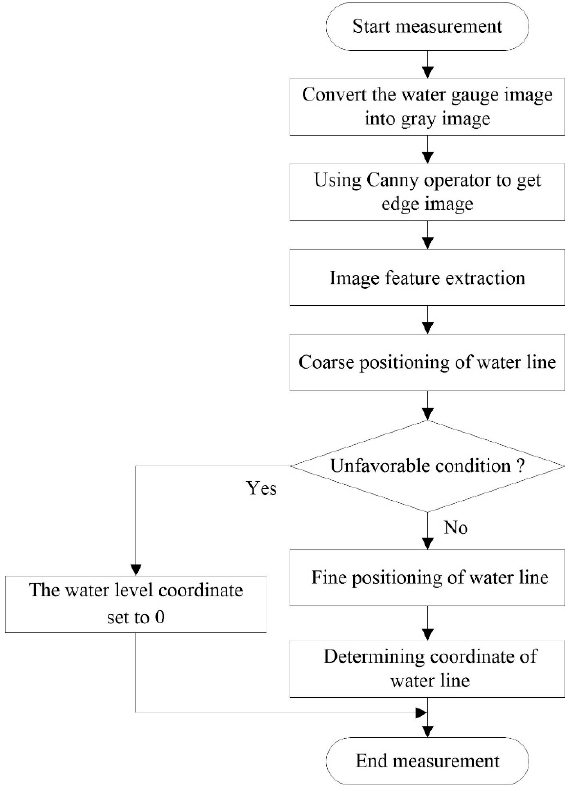
Figure 6. Maximum mean difference (MMD) method flow chart.